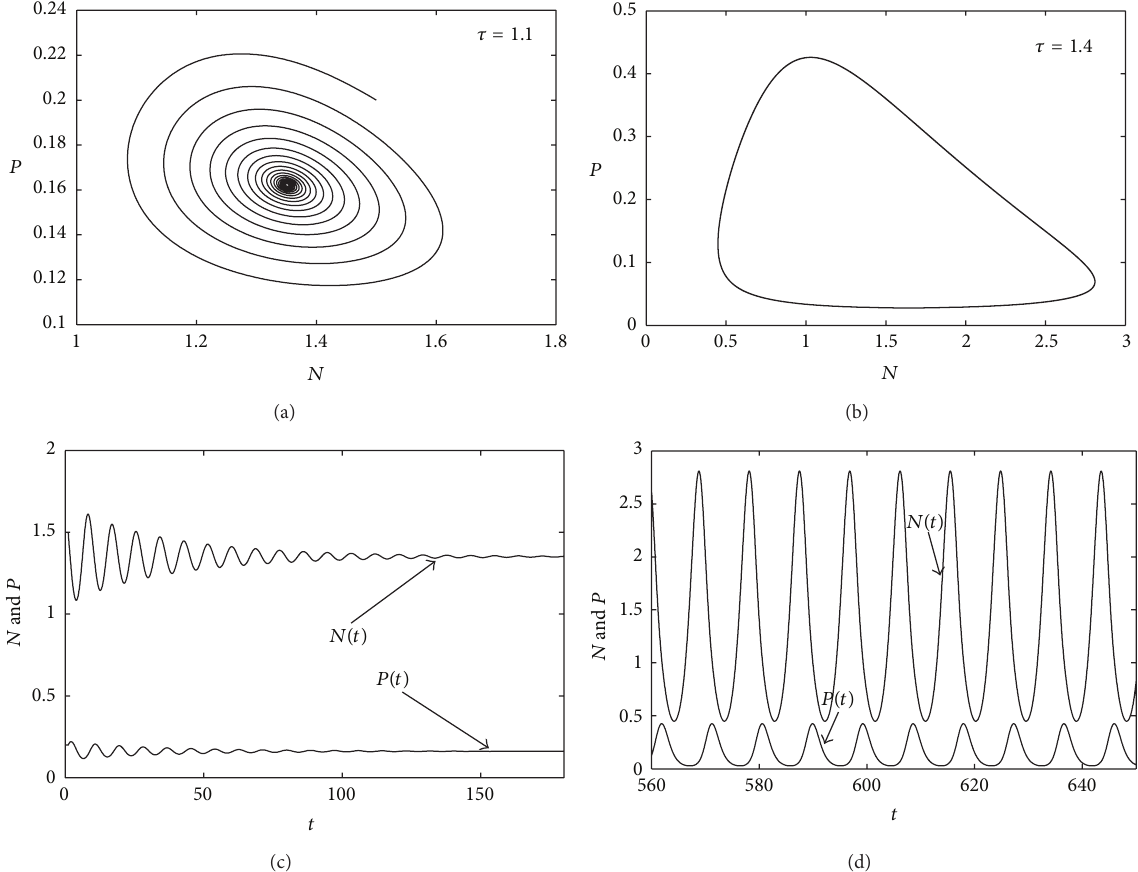
Figure 1: The stability of unique positive equilibrium 𝐸 2 . (a), (c) The equilibrium 𝐸 2 is stable for 𝜏 = 1.1 . (b), (d) The equilibrium 𝐸 2 is unstable and a stable periodic solution appears for 𝜏 = 1.4